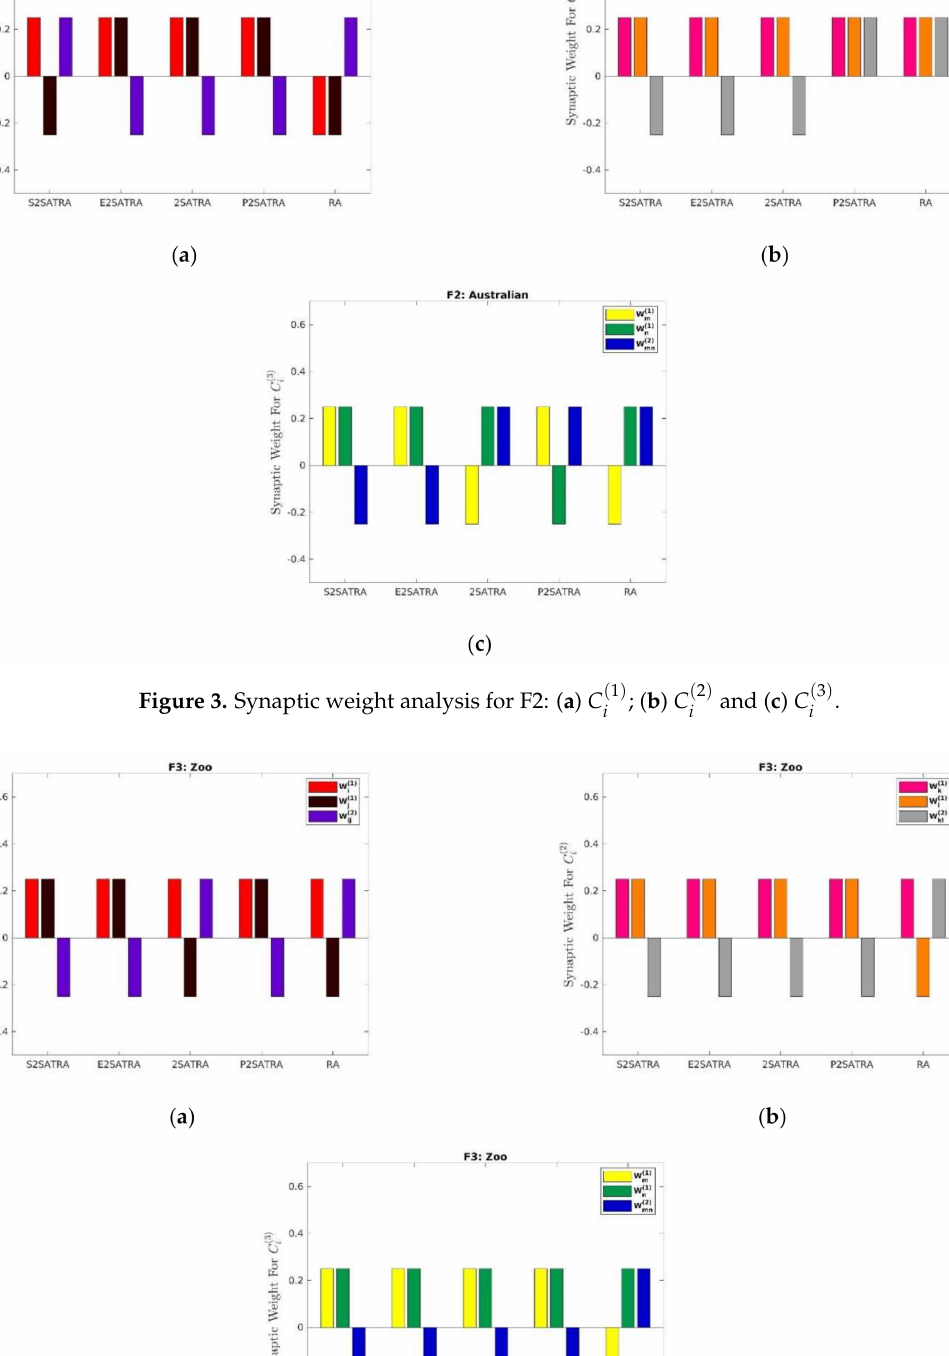
( 1 ) ( 2 ) ; ( b ) C and ( c ) C i i